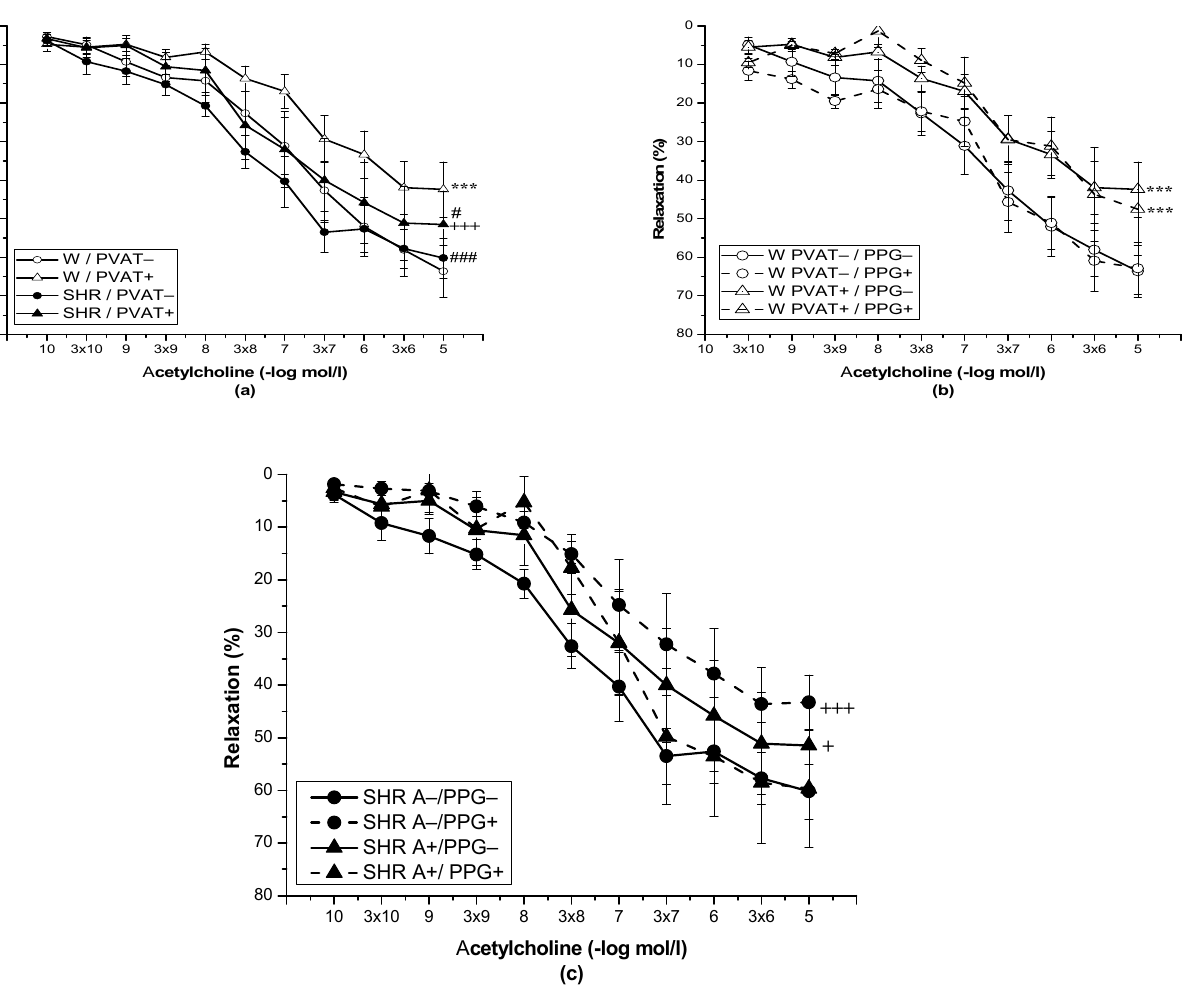
Figure 2. Endothelium-dependent vasorelaxation of the thoracic aorta of normotensive Wistar rats (W, n = 8) and spontaneously hypertensive rats (SHRs, n = 8) with intact (PVAT+) or removed (PVAT − ) perivascular adipose tissue ( a ) before (PPG − ) and after (PPG+) pretreatment with DL-propargylglycine ( b , c ). The results are presented as the mean ± S.E.M., and differences between groups were analyzed by three-way ANOVA with the Bonferroni post hoc test on ranks. *** p < 0.001 vs. W PVAT − /PPG − ; +++ p < 0.001 vs. SHR PVAT − /PPG − ; # p < 0.05 vs. W PVAT+; ### p < 0.001 vs. W PVAT+; + p < 0.05 vs. SHR PVAT − /PPG − . The effect of strain (F (1;184) = 74.94, p = 4.66 × 10 − 15 ) on vasoactive responses